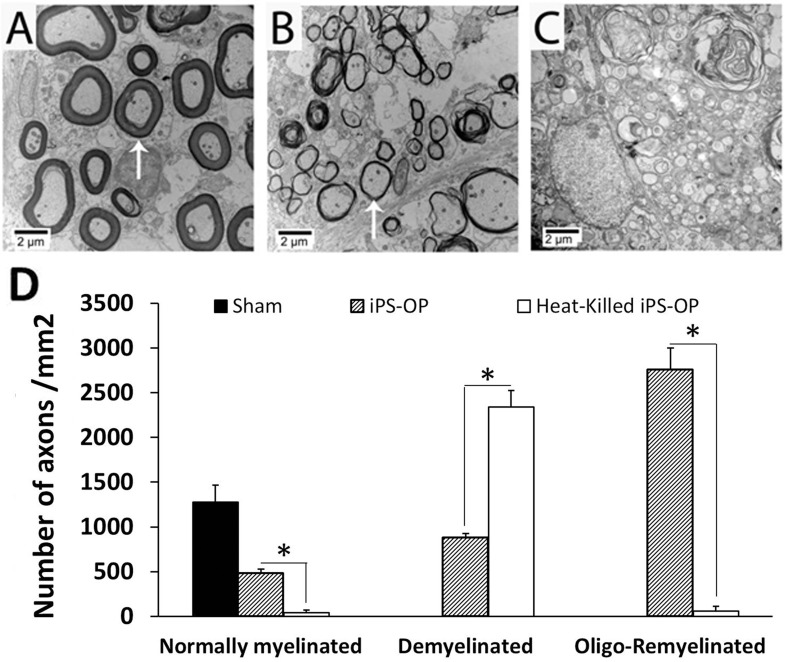
Transmission electron microscopy of transverse sections of the spinal cord showed remyelination of spared axons by BC1-derived iPS-OP cells after contusive SCI in rats.(A) Normal, endogenous myelination of an uninjured rat spinal cord (laminectomy sham control) as indicated by white arrows, showing thick and tightly-packed myelin sheaths. (B) Remyelination observed in rats transplanted with BC1-derived OPs, approximately two months after transplantation. These are sites where oligodendrocytes are detected, as shown in Fig. 4. The relatively thinner and loosely packed myelin sheaths may be compared with the normal condition in (A), suggesting that this is remyelination by human OPs. (C) Multiple nude axons are visible in rats injected with heat-killed iPS-OPs, with no observable remyelination, approximately two months after transplant. (D) Quantification shows that transplantation of BC1-derived OPs resulted in a significant increase in the number of remyelinated axons and reduced demyelinated of axons compared with the heat-killed iPS-OP group. Values in the graphs represent mean ± SEM. * denote statistical significance compared to heat-killed iPS-OPs by Tukey post hoc tests. Ten images encompassing the injury epicenter from 4 rats were analyzed for each treatment group (P < 0.001). Magnification (A-C): 10000X.